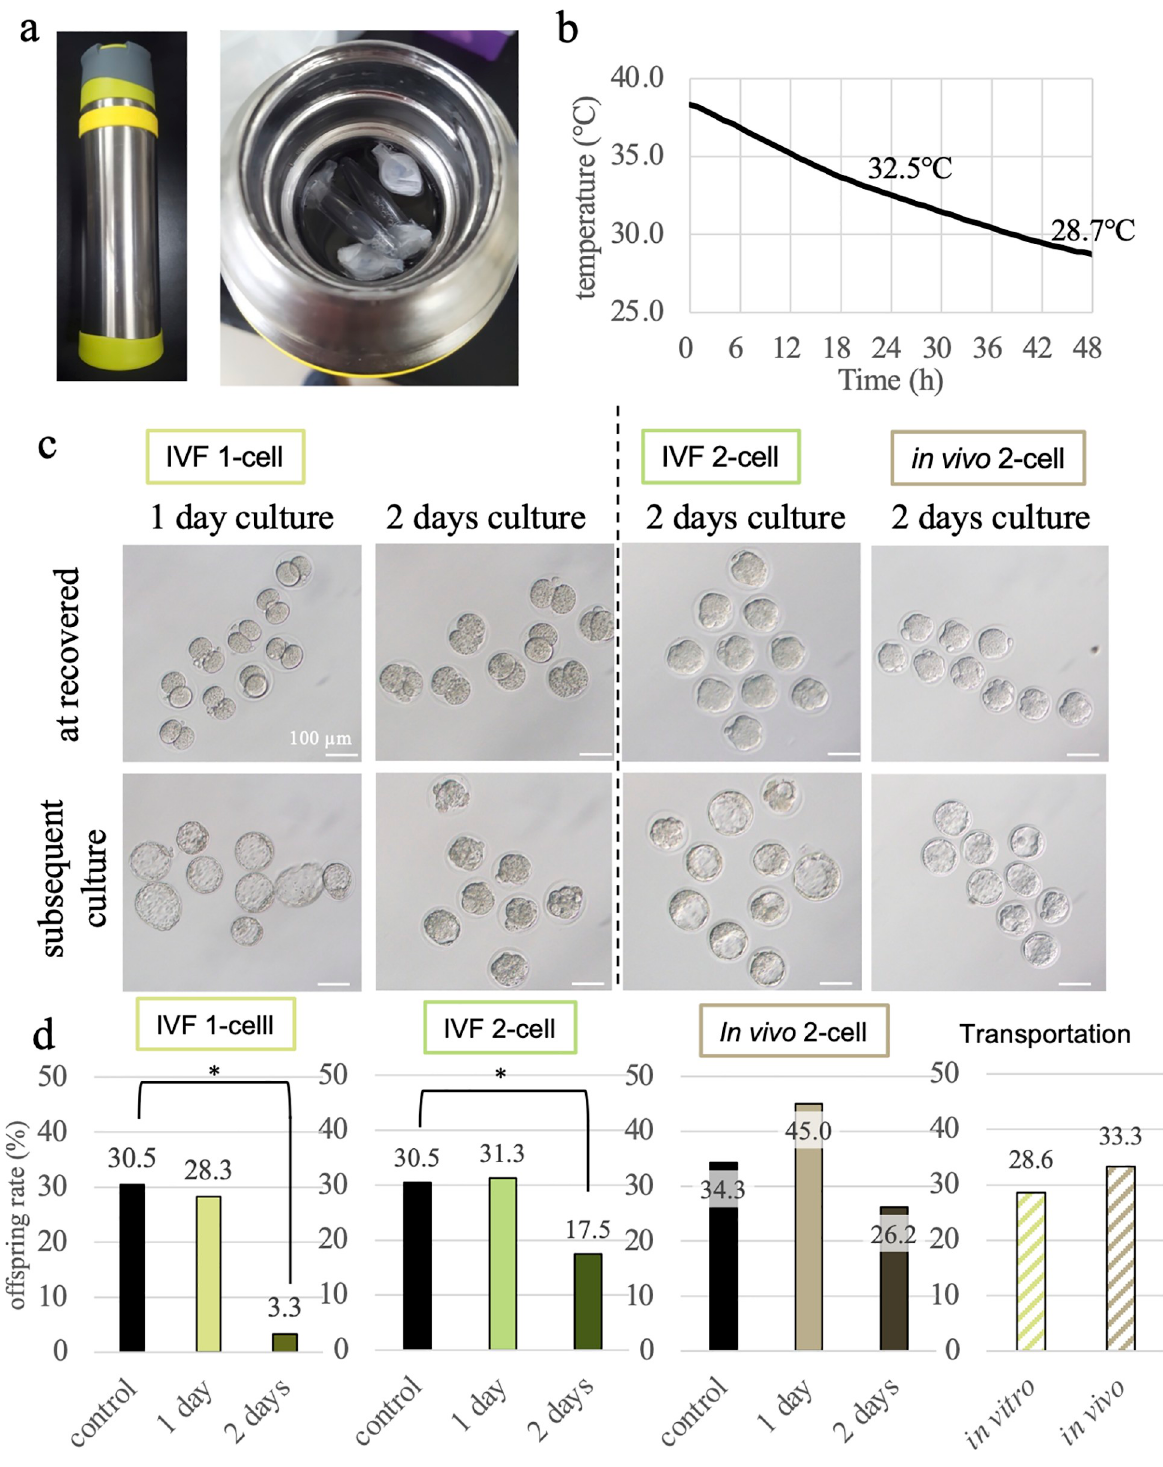
Fig 3. Embryo culture in the thermal bottle. (a) The thermal bottle used in this study is commercially available (left). Microtubes with OptC medium and embryos were put in the bottle containing 38.5˚C water (right). (b) Water temperature in the thermal bottle was measured for 48 h. (c) Embryos at the time of collection from the thermal bottle (upper) and embryos cultured for 3 to 4 days in a CO 2 incubator after collection (lower). (d) The birth rates of offspring derived from embryos cultured in the thermal bottle for 1 or 2 days.